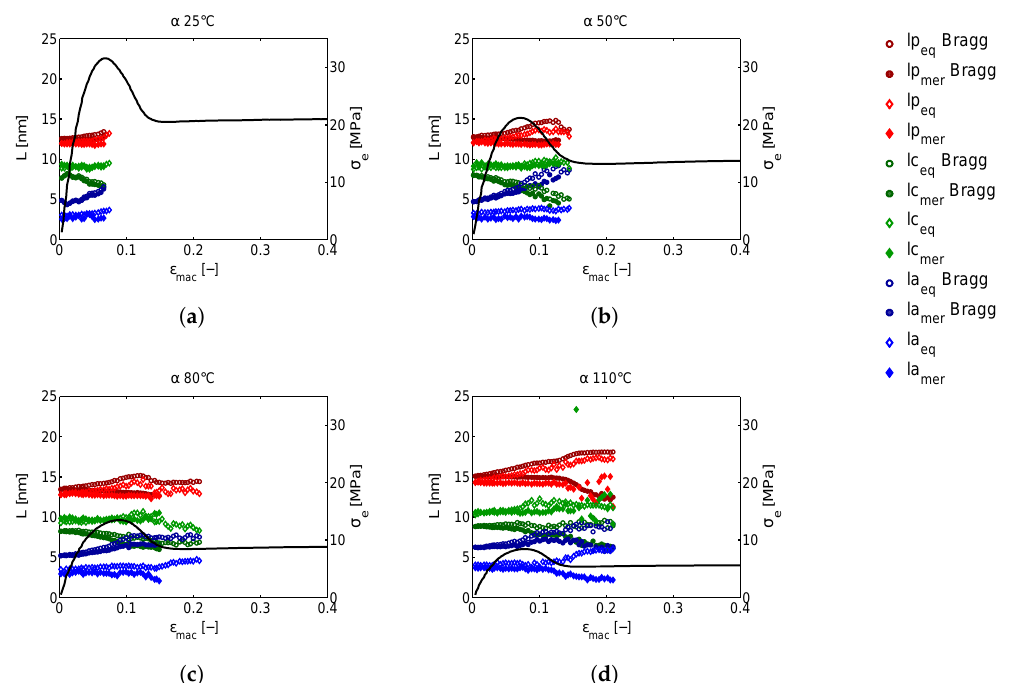
Figure A2. Long period, amorphous layer thickness and lamellar thickness determined via Bragg’s law and the 1D autocorrelation function versus the macroscopic strain for α -iPP, elongated at 25, 50, 80 and 110 ◦ C.